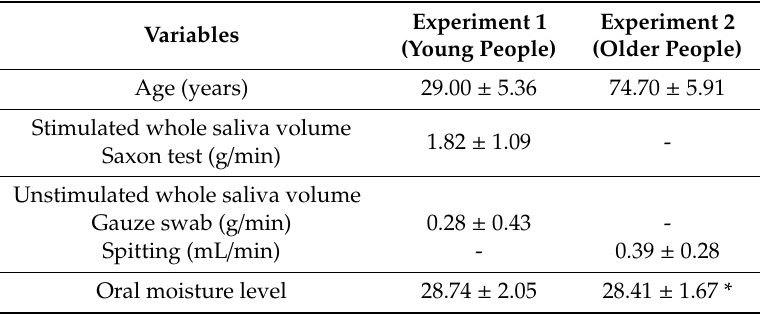
Table 1. Means and standard deviations of each